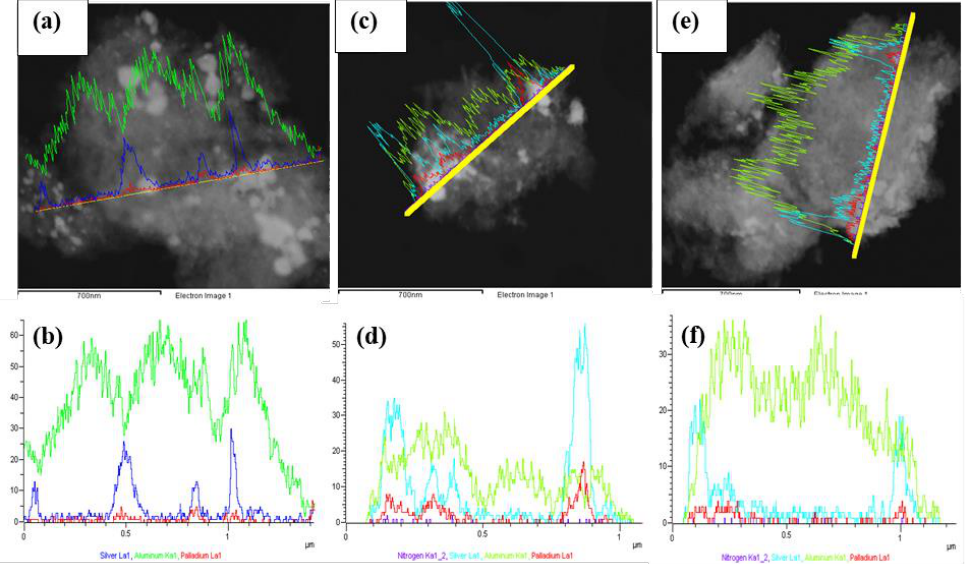
Figure 7. STEM-EDX line scans over the used catalysts showing ( a ) BSE image of 1Pd9Ag/Al 2 O 3 ; ( b ) combined line scans of Pd, Ag, and Al; ( c ) BSE image of 1Pd9Ag-14%[N 4444 ][NO 3 ], ( d ) combined line scans of Pd, Ag, Al, and N; ( e ) BSE image of 1Pd9Ag-24%[N 4444 ][NO 3 ]; ( f ) combined line scans of Pd, Ag, Al, and N.